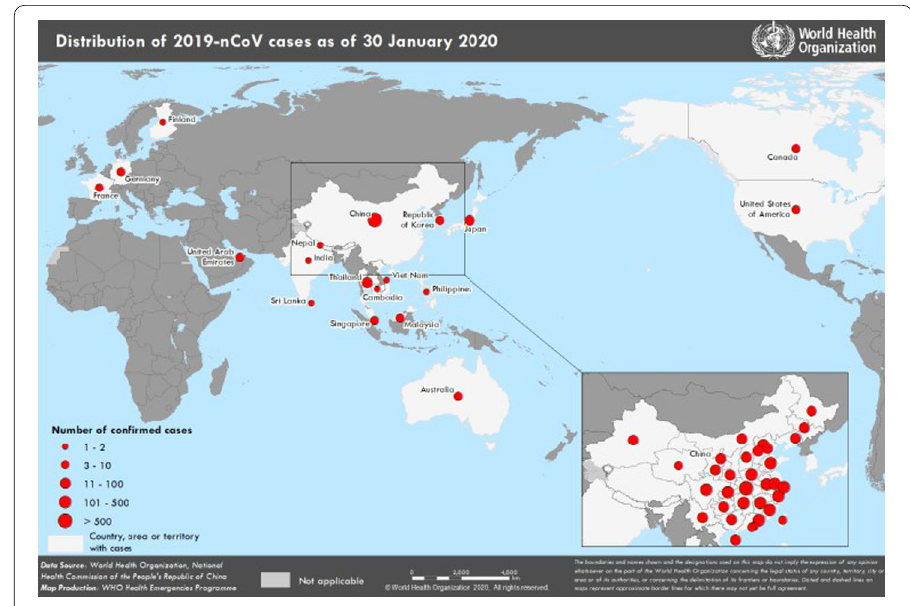
Figure 1 Concentration of COVID-19 cases worldwide as on January 30,